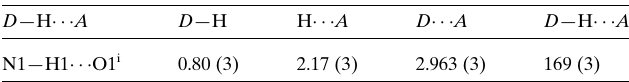
Table 1 Hydrogen-bond geometry (A˚ , (cid:2) ).